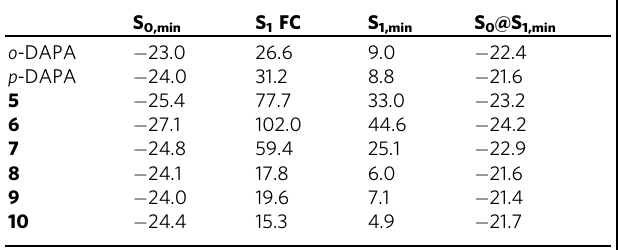
Table 2 Calculated NICS(1) zz values for emissive DAPA isomers and derivatives a